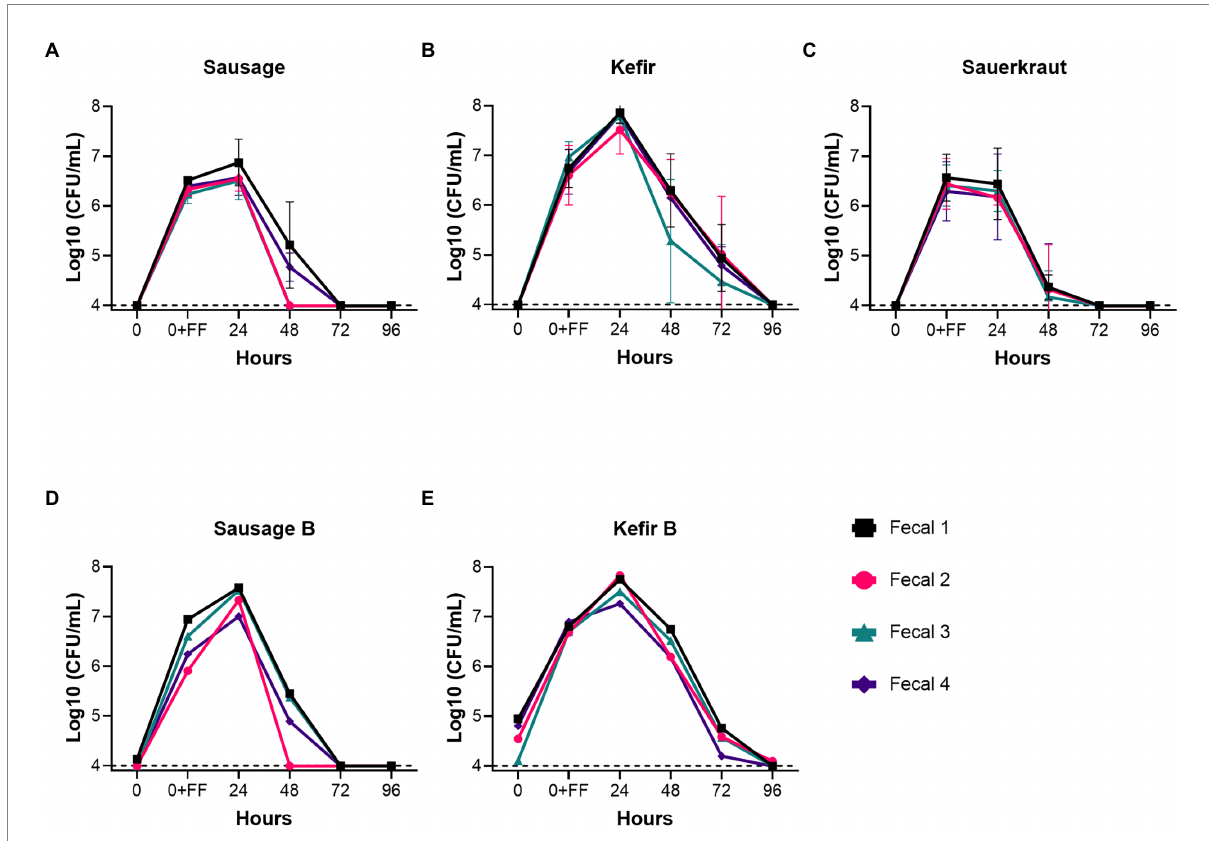
FIGURE 2 Fermented food-associated Lactobacillaceae were unable to persist under conditions simulating the distal GI tract. The persistence of Lactobacillaceae from two commercial brands of sausage (A,D) , two commercial brands of kefir (B,E) , or sauerkraut (C) , was monitored over time (0–96 h) by qPCR in simulated gastrointestinal environments colonized with microbes from one of four fecal samples. Samples were collected at the time points indicated. The dashed line designates the limits of detection (10 4 CFU/mL). Each colored line indicates a unique fecal microbiota (Fecal 1, black squares; Fecal 2, pink circles; Fecal 3, teal triangles; Fecal 4, purple diamonds). Values for the graphs in (A–C) are the mean + SD of two biological